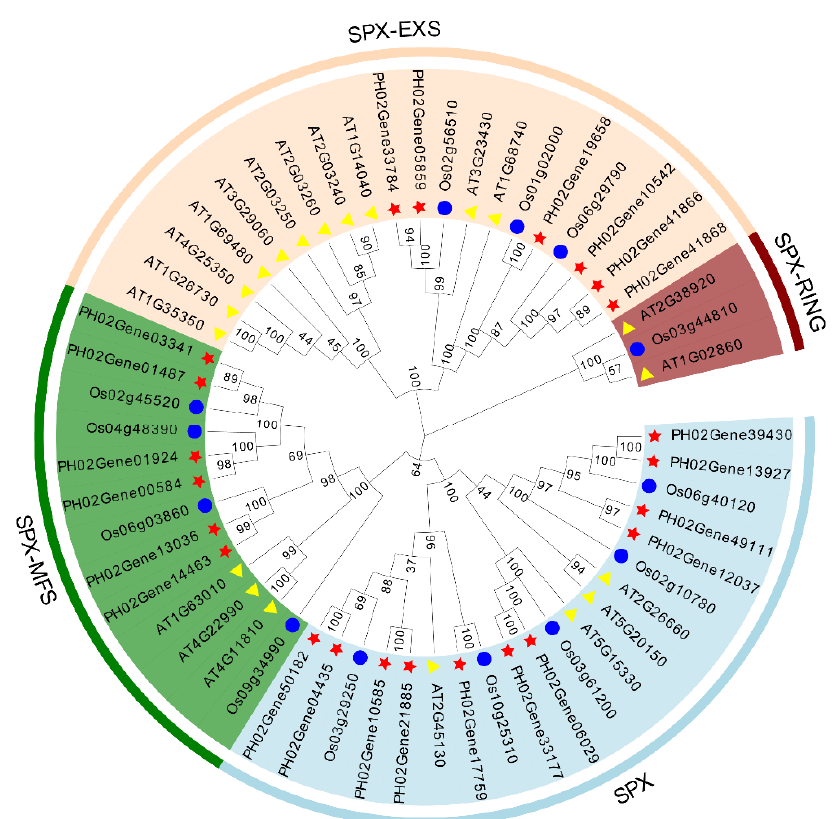
Figure 2. Phylogenetic analysis of the SPX-domain-containing protein genes in Phyllostachys edulis , Arabidopsis thaliana , and Oryza sativa . The phylogenetic tree was constructed with the neighbor-joining (NJ) algorithm and 1000 bootstrap replicates. Different colors indicate the different subfamilies of SPX-domain-containing proteins.